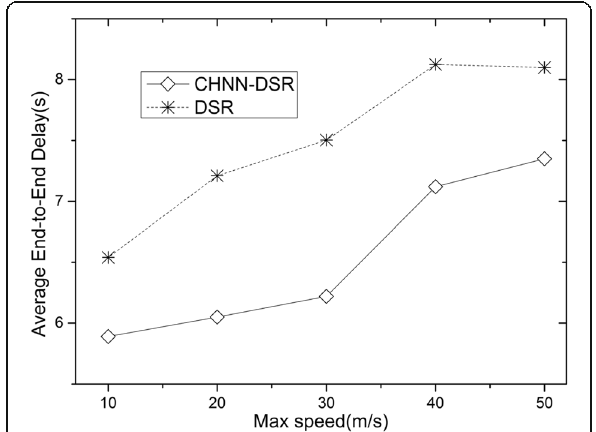
Fig. 5 Throughput simulation results for DSR and CHNN-DSR. The simulation results of the throughput for CHNN-DSR and DSR under the change of node movement